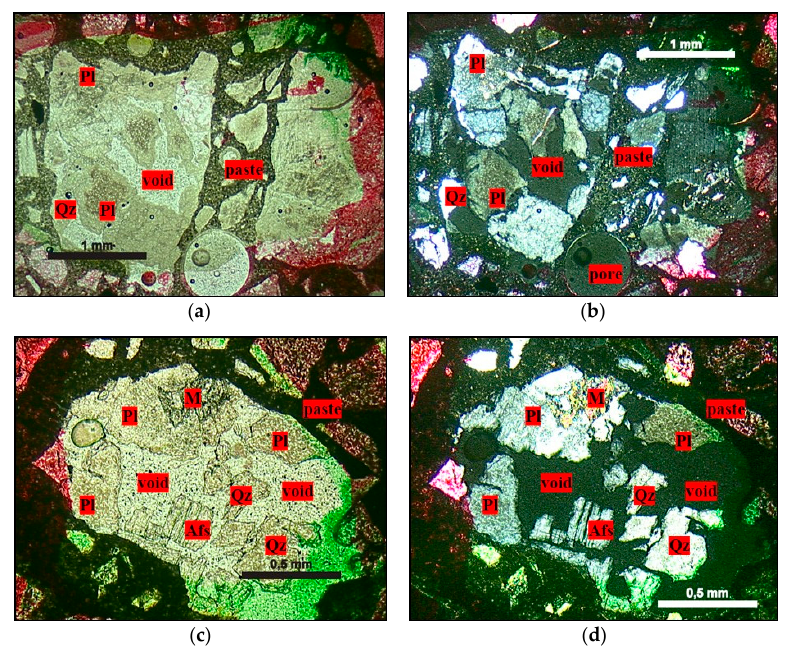
Figure 13. Micrographs obtained by optical microscopy showing quartz dissolution in mortars submitted to the accelerated mortar bar test, where Qz = quartz, Pl = plagioclase, Afs = K-feldspar, and M = mica. ( a , b ) Natural light and crossed polarizer, 2.5× magnification; ( c , d ) crossed polarizer, 5× magnification.